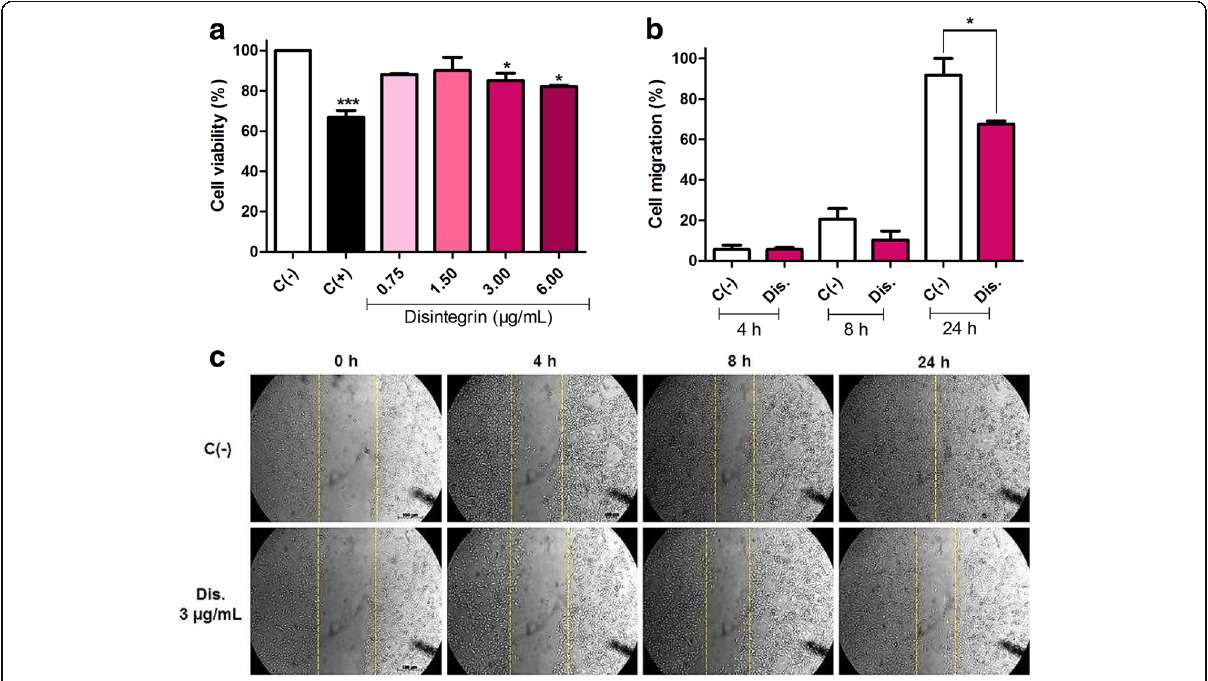
Fig. 4 Functional assays with MDA-MB-231 cells. a Cell viability (%) after 24 h of treatment with disintegrin (0.75 – 6.00 μ g/mL). C ( − ) – negative control (PBS); C (+) – positive control (MMS – 300 μ M). The results were analyzed by ANOVA, followed by Dunett ’ s post-hoc test (* p < 0.05). b and c Cell migration after different times (0, 4, 8 and 24 h) of treatment with non-RGD disintegrin (3 μ g/mL). C ( − ) – negative control (PBS). The dashed yellow lines delimit the region where no cell growth is observed. Data ( n = 3) are presented as mean ± SD, which were analyzed by Student ’ s t test (* p <